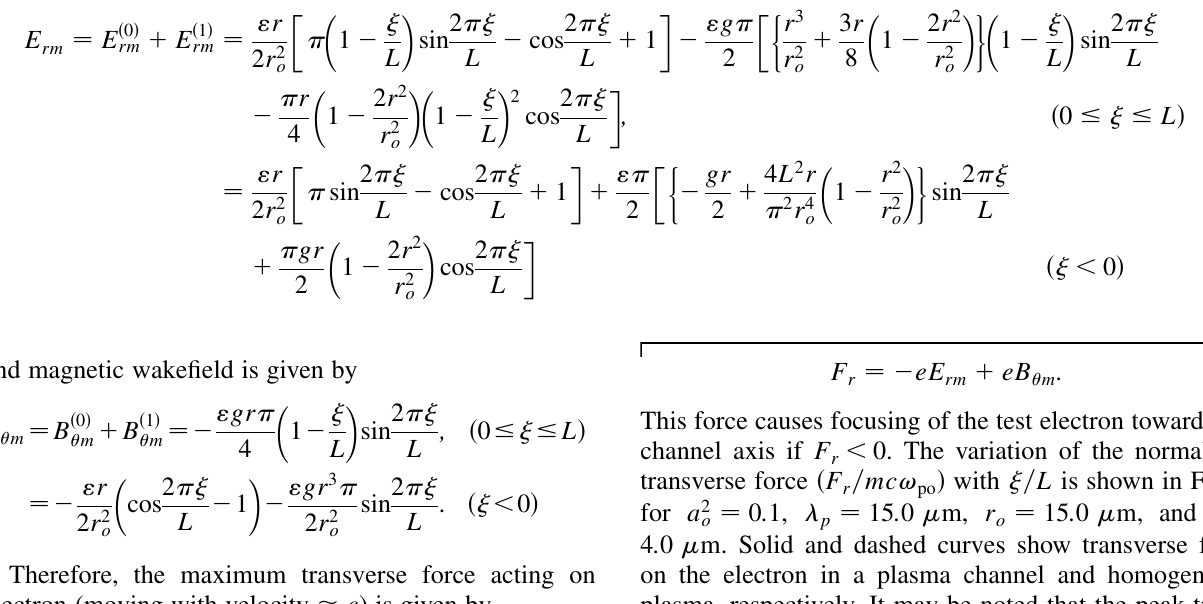
FIG. 2. Normalized axial force (cid:3) F curve) and in a homogeneous plasma (dashed curve) for a 2